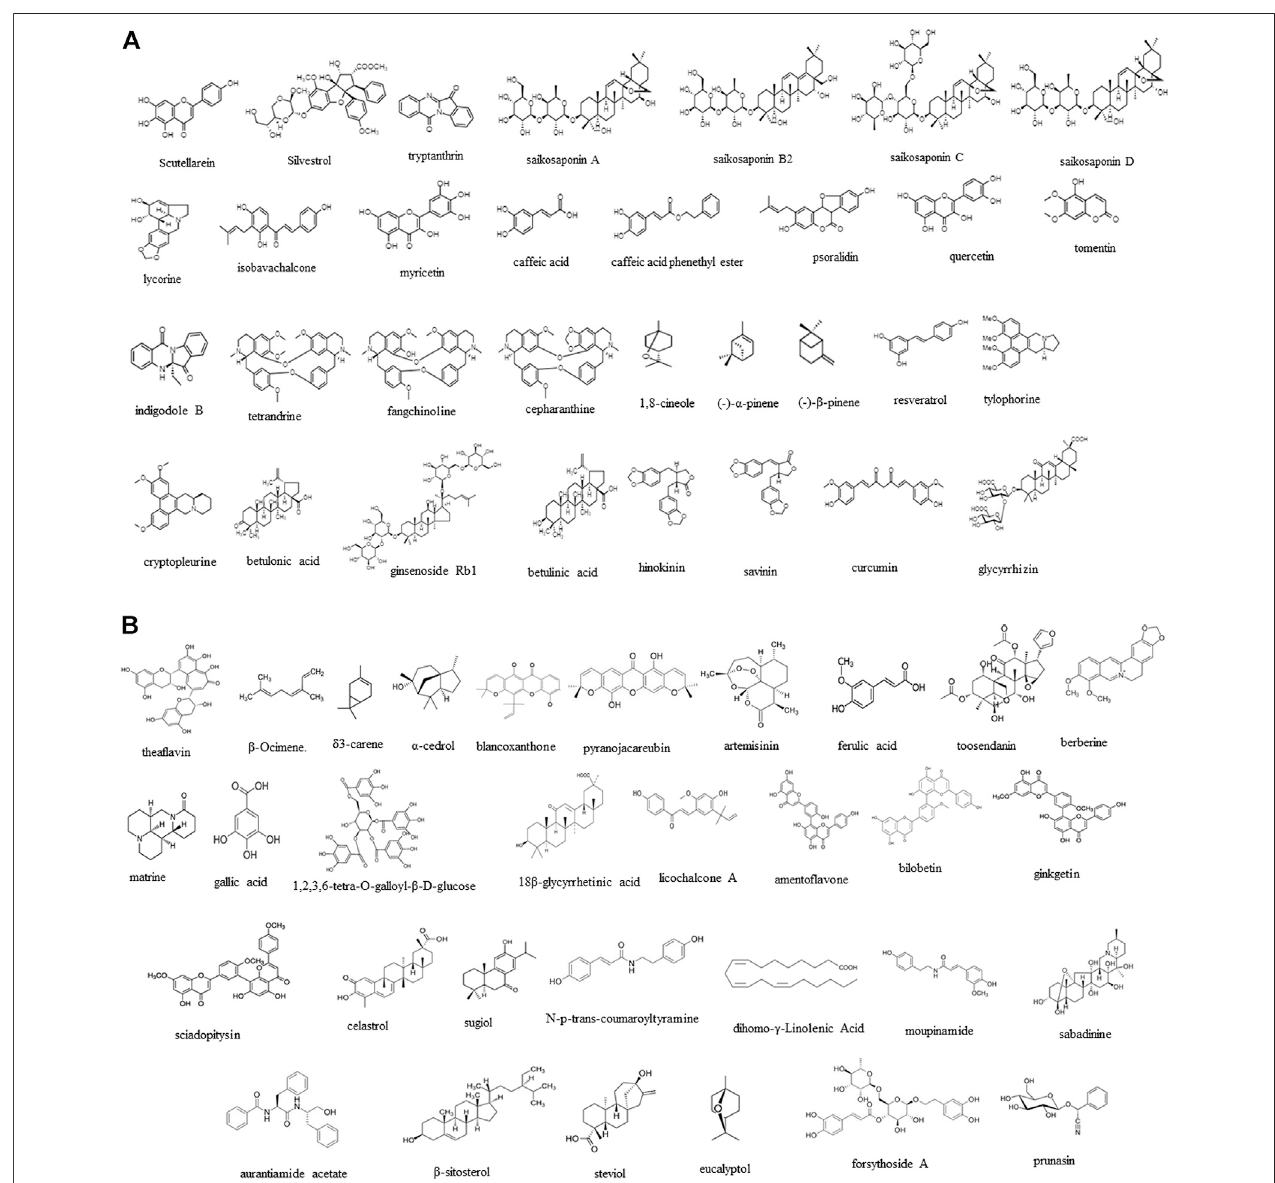
FIGURE2|(A – E) MolecularstructuresexperimentallyeffectiveforSARS-CoVtherapeutictarget.Scutellarein(CASNo:529 – 53-3),silvestrol(CASNo:697235-38- 4), tryptanthrin (CAS No: 13220-57-0), saikosaponin A (CAS No: 20736-09-8), saikosaponin B2 (CAS No: 58316-41-9), saikosaponin C (CAS No: 20736-08-7), saikosaponin D (CAS No: 20874-52-6), lycorine (CAS No: 476-28-8), isobavachalcone (CAS No: 20784-50-3), myricetin (CAS No: 529-44-2), caffeic acid (CAS No: 331-39-5),caffeicacidphenethylester(CASNo:104594-70-9),psoralidin(CASNo:18642-23-4),quercetin(CASNo:117-39-5),tomentin(CASNo:28449-62-9), indigodole B, thea fl avin (CAS No: 4,670 – 05-7), β -ocimene (CAS No: 3,338 – 55-4), δ 3-carene (CAS No: 13,466 – 78-9), α -cedrol (CAS No: 77 – 53-2), blancoxanthone (PubChem CID: 11703574), pyranojacareubin (CAS No:78,343 – 62-1), artemisinin (CAS No: 63,968 – 64-9), ferulic acid (CAS No: 1,135 – 24-6), toosendanin (CAS No: 58,812 – 37-6), berberine (CAS No: 633 – 65-8), matrine (CAS No: 519 – 02-8), gallic acid (CAS No:149 – 91-7), 1.2,3,6-tetra-O-galloyl- β - D -glucose (CAS No: 79,886 – 50- 3), 18 β -glycyrrhetinic acid (CAS No: 471 – 53-4), licochalcone A (CAS No: 58,749 – 22-7), amento fl avone (CAS No:1,617 – 53-4), bilobetin (CAS No: 521 – 32-4),